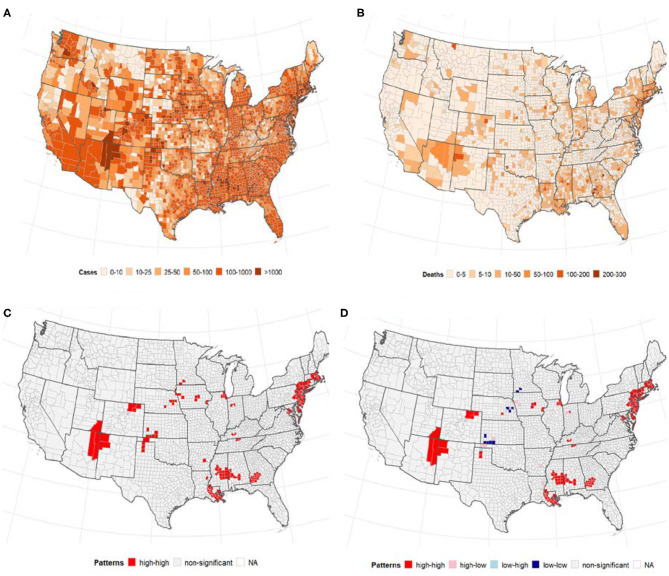
The number of confirmed cases of COVID-19 and deaths per 100, 000 population by US county. Note: Visual effects may be distorted due to the large area of US counties in the West compared to the East. (A) Cases/100,000 population. (B) Deaths/100,000 population. (C) Univariate LISA cases/100,000. (D) Univariate LISA deaths/100,000.